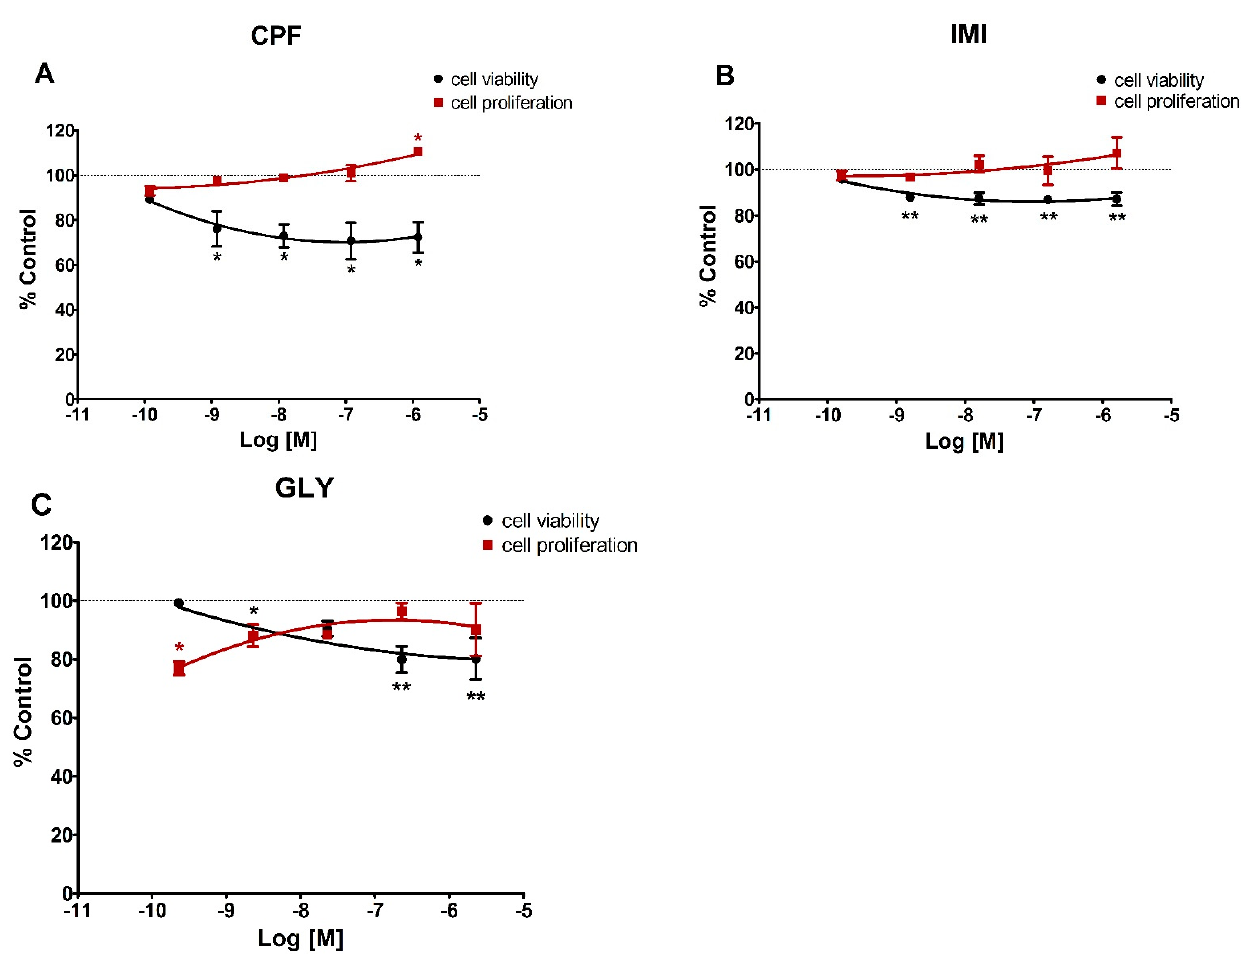
Figure 1. Dose-response curves for cell viability (black) and cell proliferation (red) assays in MCF-7 cells treated for 72 h with CPF ( A ), IMI ( B ) or GLY ( C ). Values are means ± SEM of three independent experiments with control cells set at 100%. Asterisks indicate statistically significant differences with respect to control cells: * p < 0.05; ** p < 0.01.